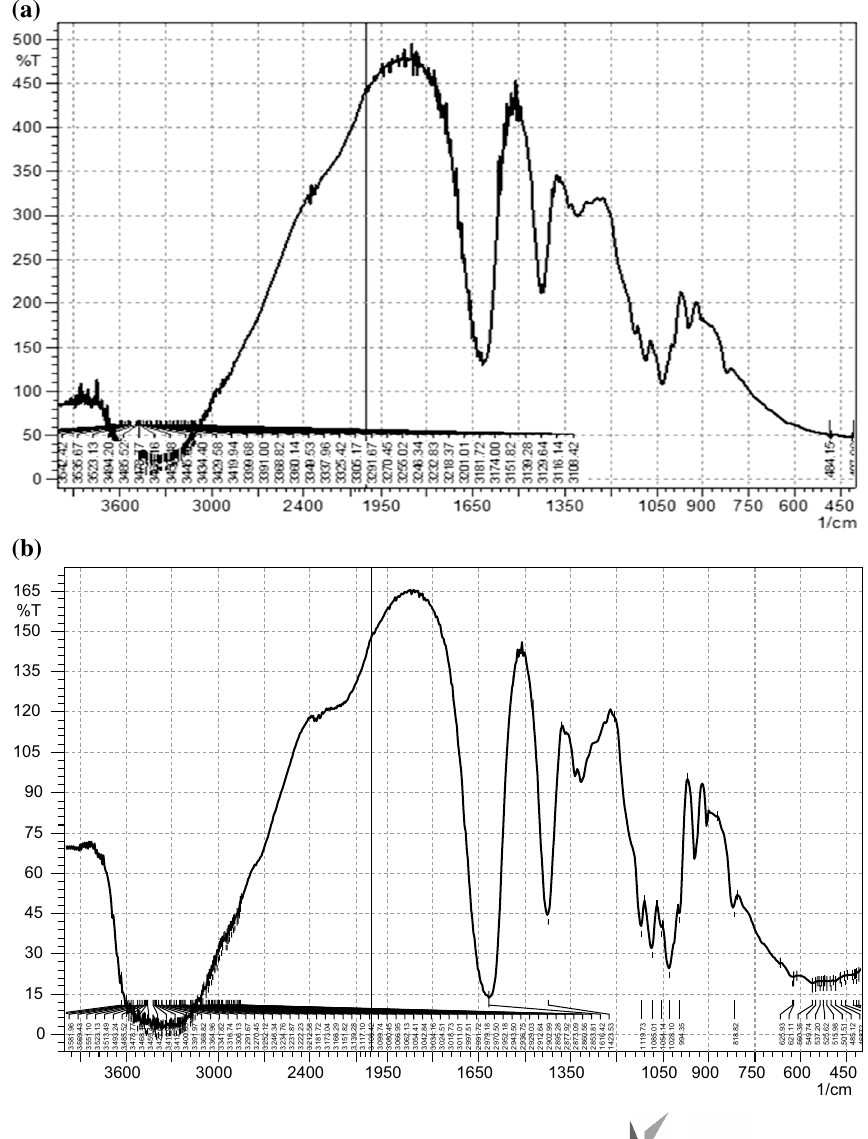
Fig. 1 FT-IR spectrum a Cd(II)- loaded algal biomass and, b unloaded algal